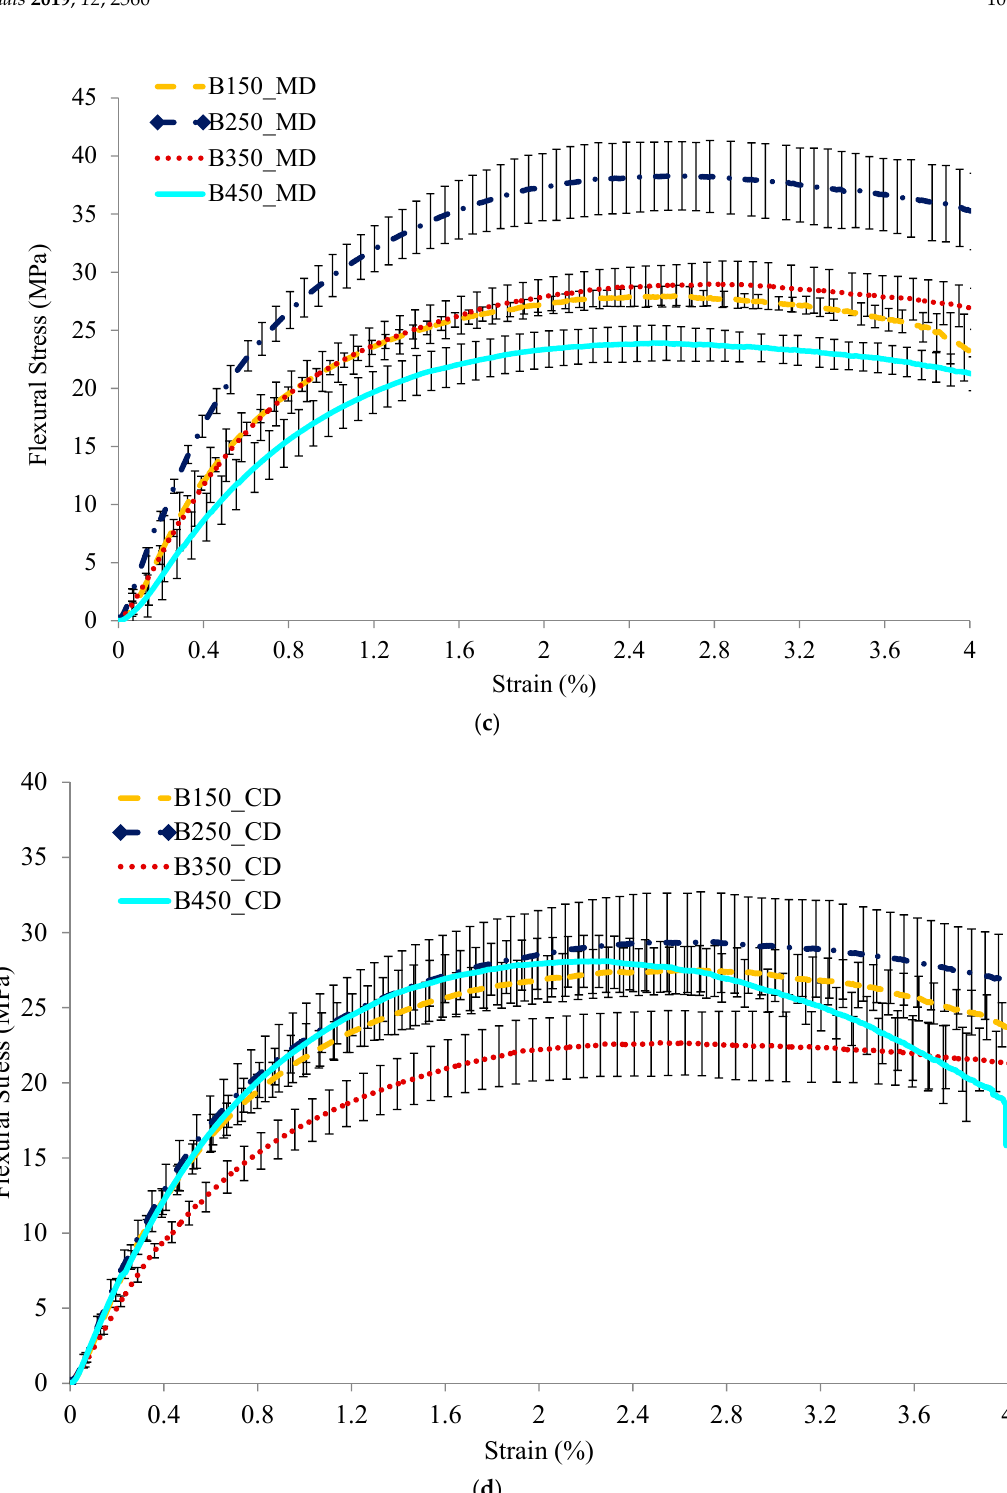
Figure 5. Bending behaviour of nonwoven composites. ( a ) set A in MD, ( b ) set A in CD, ( c ) set B in MD, and ( d ) set B in CD.